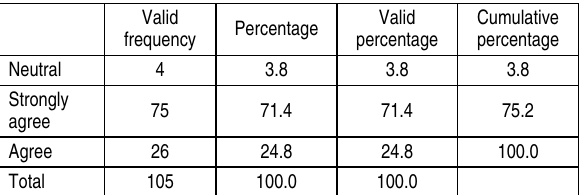
Table 19. Issue of failure in SMME manufacturers